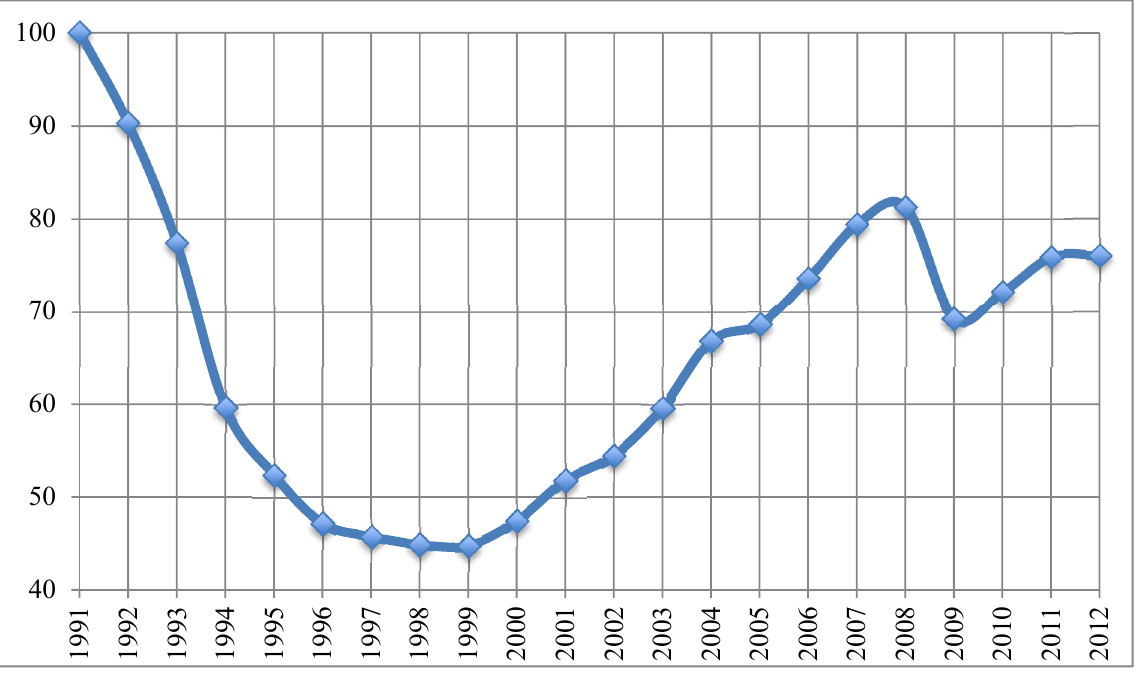
Figure 2. Dynamics of GDP (PPP) in Ukraine in 1991–2010, in billion dollars 2005. Source : World Bank